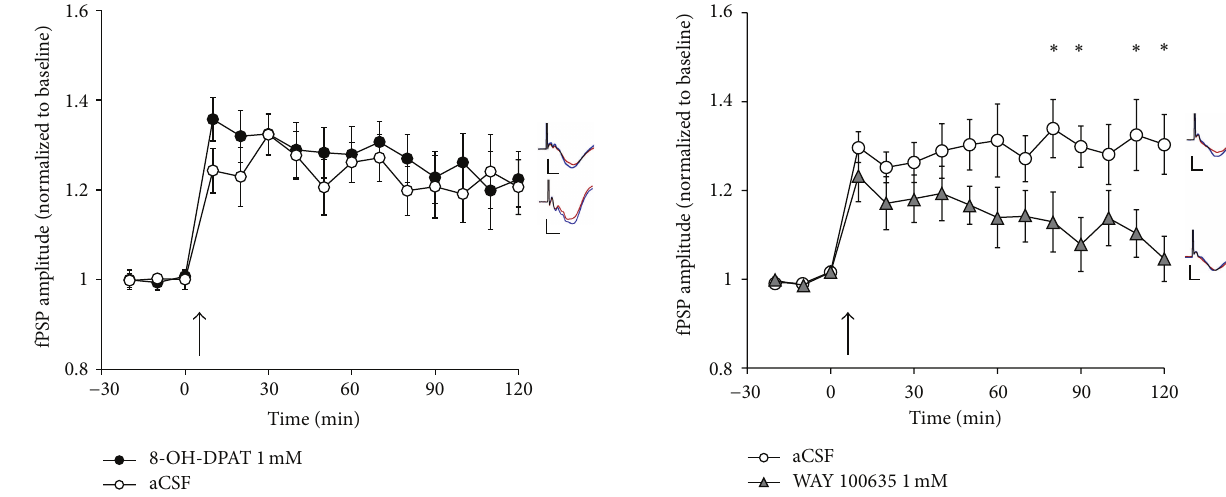
Figure 6: The effect of application (in V1 by means of reverse microdialysis) of either aCSF ( 𝑛 = 8 ; same group as in Figure 3) or 8-OH-DPAT (1mM, 𝑛 = 8 ) on LTP following TBS (at arrow) of the LGN in urethane-anesthetized rats. Application of 8-OH-DPAT did not result in a significant change in LTP relative to animals receiving aCSF. Inserts depict typical fPSPs before (red) and after (blue) LTP induction in the presence of 8-OH-DPAT (top) and aCSF (bottom; calibration bars indicate 0.5 mV vertical and 10ms horizontal; each fPSP trace is an average of 30 min of continuous recording).